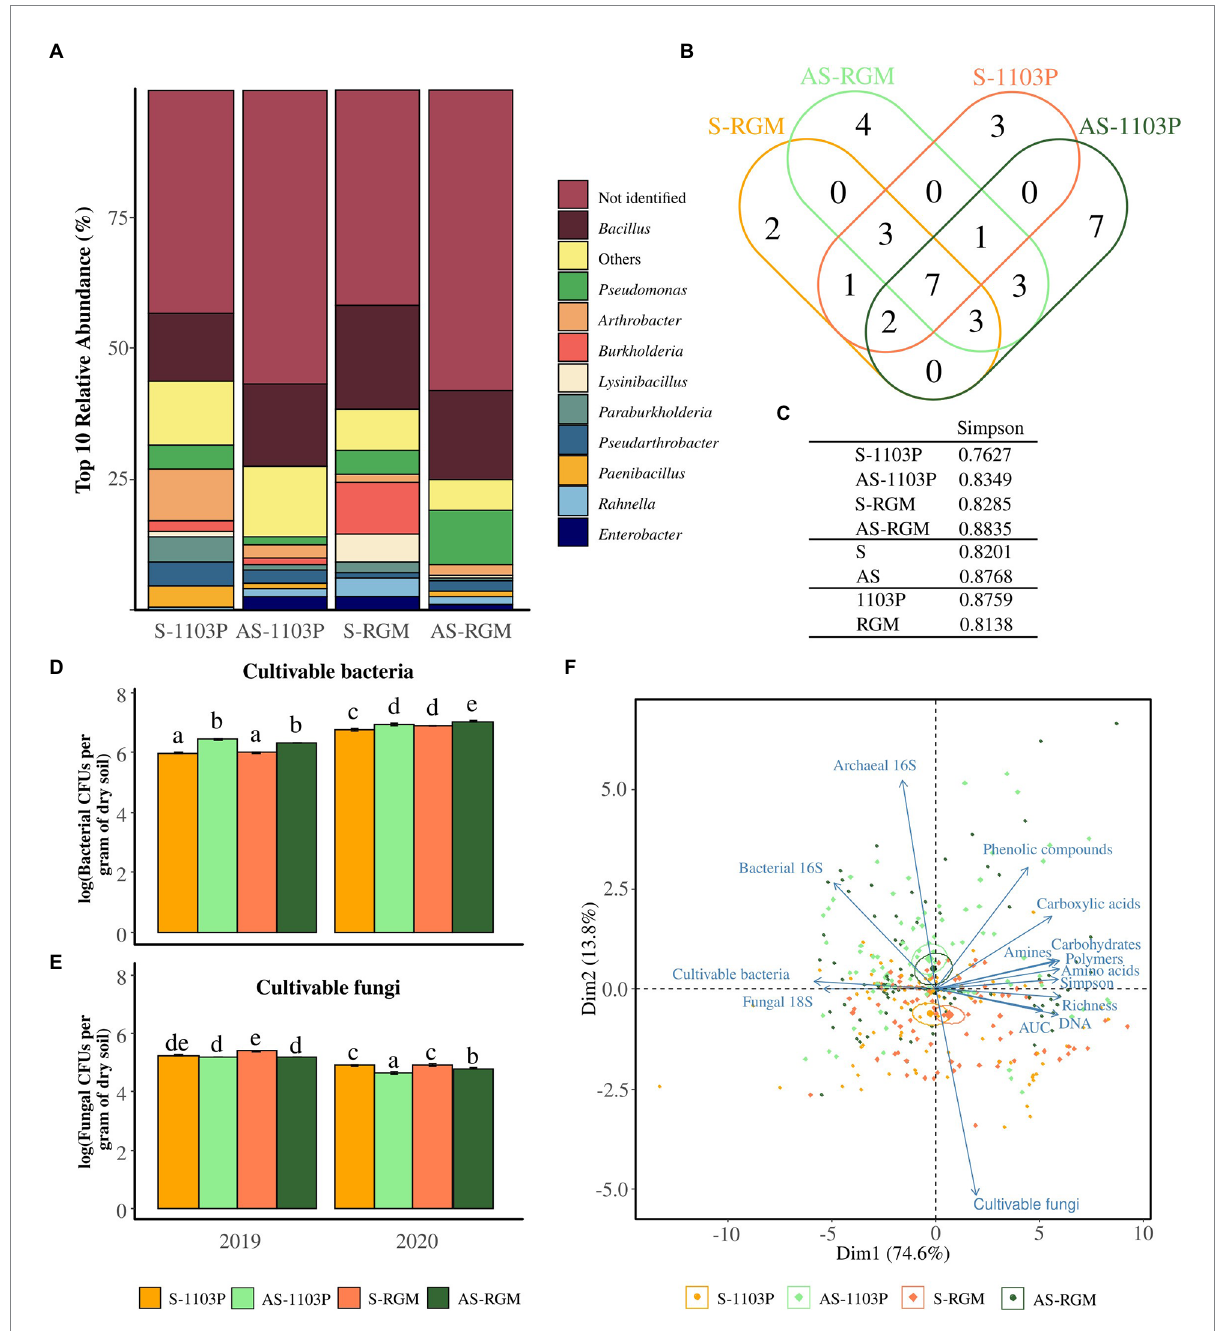
FIGURE 3 Microbial profile using cultivable-based approaches and q-PCR in the rhizosphere of grapevine plants after 4.5 months of growth in S and AS soils in the greenhouse. Diversity of cultivable bacteria isolated from rhizosphere and identified among the 4 conditions through MALDI-TOF-MS, demonstrated by (A) the relative abundance of the top 10 taxa at the genus level, (B) the Venn diagram illustrating the overlap of the genera, and (C) the associated Simpson’s diversity index. Histograms representing the level of populations of cultivable (D) bacteria and (E) fungi for 2019 and 2020 experiments. Bars represent means ± SE ( n = 3), different letters indicate significantly different means according to pairwise comparisons based on Student t tests ( p < 0.05). (F) Ordination biplot of principal component analysis (PCA) for level of cultivable microorganisms, Eco-Plates measurements (Area Under AWCD Curve = AUC, Simpson’s diversity, functional richness, and the families of consumed substrates), the total DNA extracted from the rhizosphere ( n = 5) and the amplicons (fungal 18S rRNA gene, archaeal and bacterial 16S rRNA